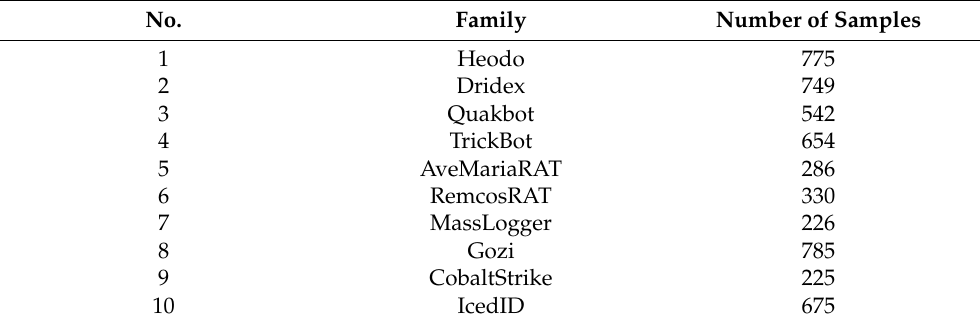
Table 1. Dataset